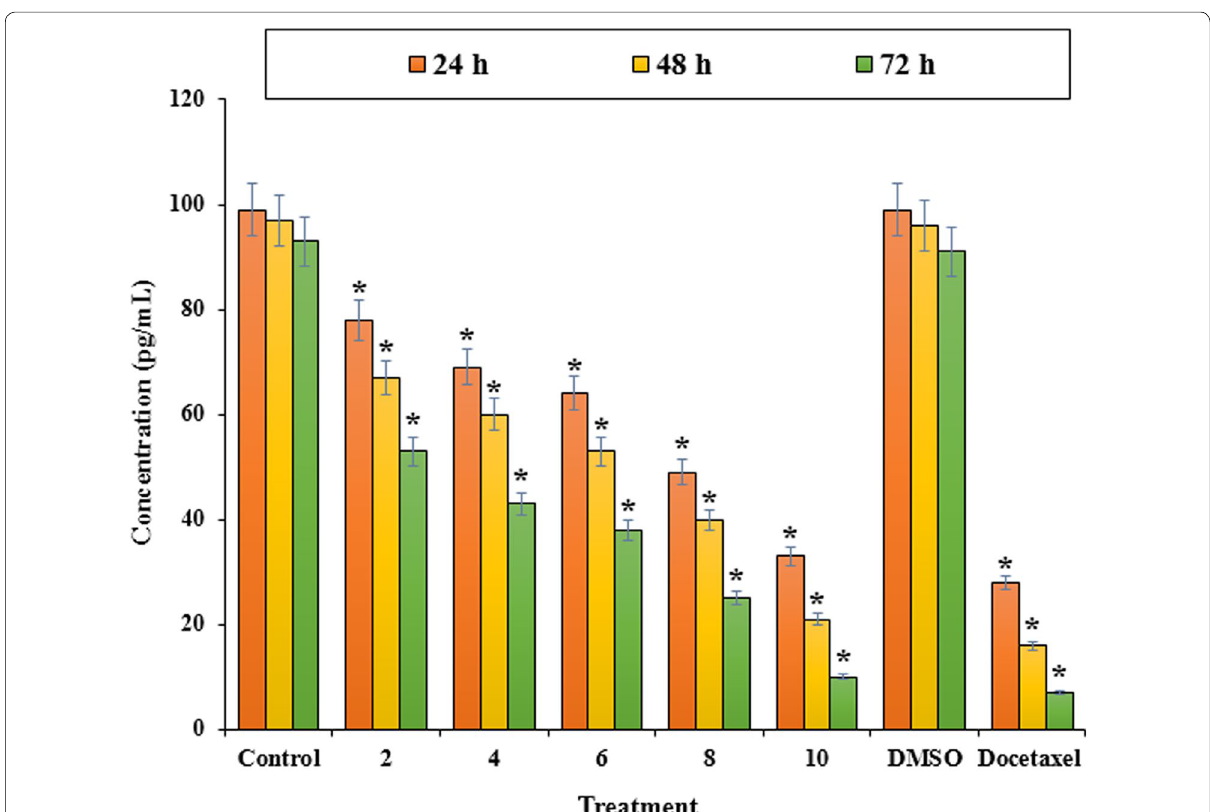
Fig. 7 The effect of L. usitatissimum extract on the concentration of Tumor Necrosis Factor-Alpha (TNF-α) of LNCaP cells. The concentration was measured by the MTT assay. LNCaP cells were treated with different concentrations of the extract for 24, 48, and 72 h. *Indicate the significant difference ( p < 0.01) between experimental groups with control/DMSO groups